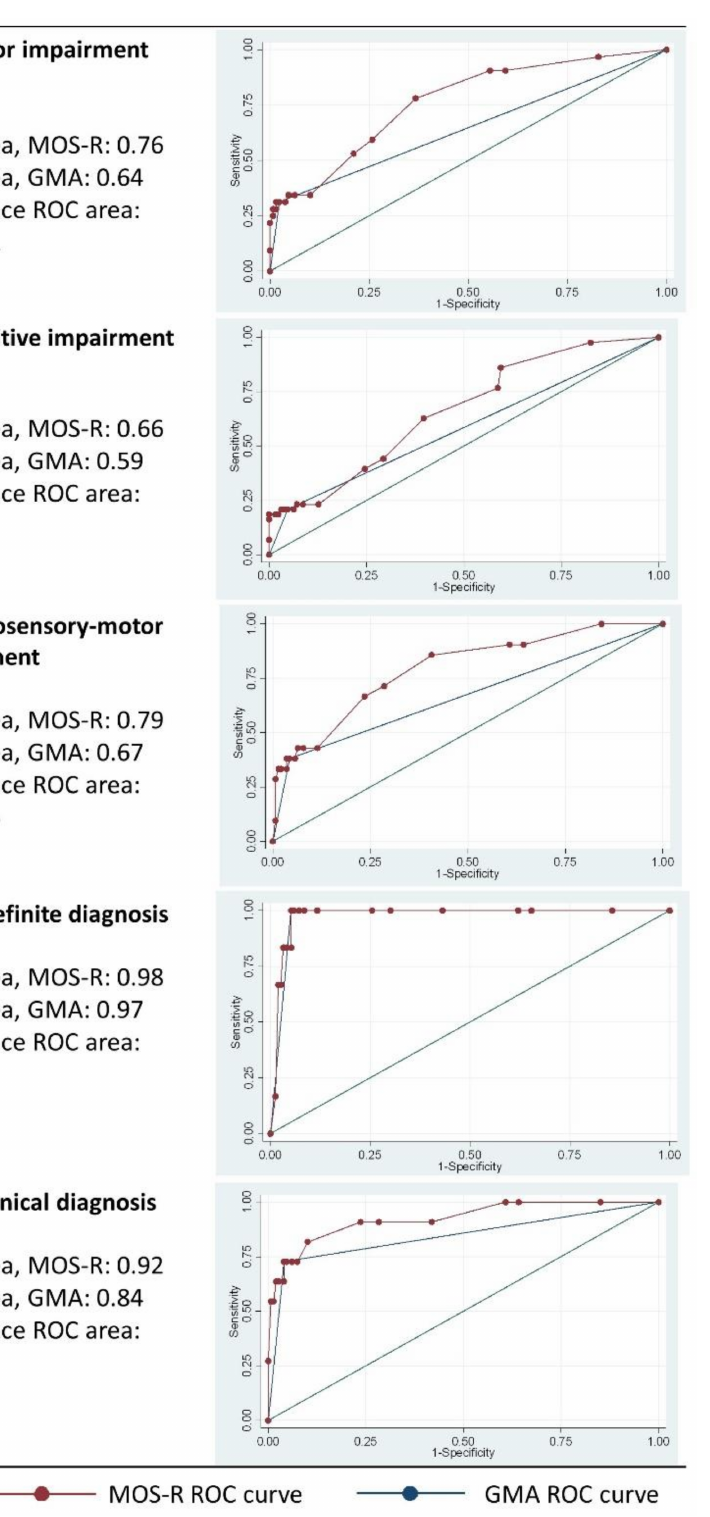
Figure 3. ( A – E ): ROC curves for several outcomes with GMA and MOS-R, testing hypothesis that AUC is not the same. MOS-R cut-off ≤ 23 for Figure 3A–C, MOS-R cut-off ≤ 15 for Figure 3D,E; Abbreviations: ROC: receiver operating characteristic; MOS-R: motor optimality score, revised; AUC: area under